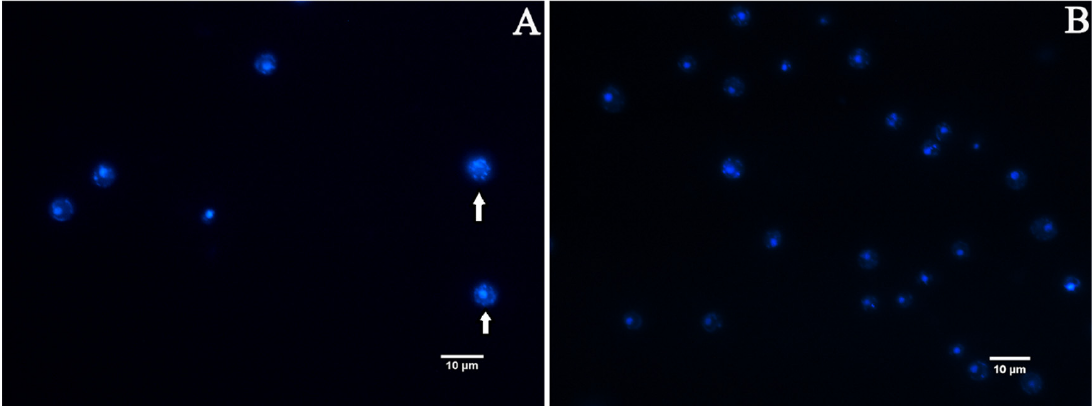
Figure 10. Effect of EA on nuclear fragmentation in C. albicans assayed by DAPI staining. ( A ) Cells exposed to 32 µ g/mL EA. ( B ) Control. Nuclear fragmentations are marked by arrow.